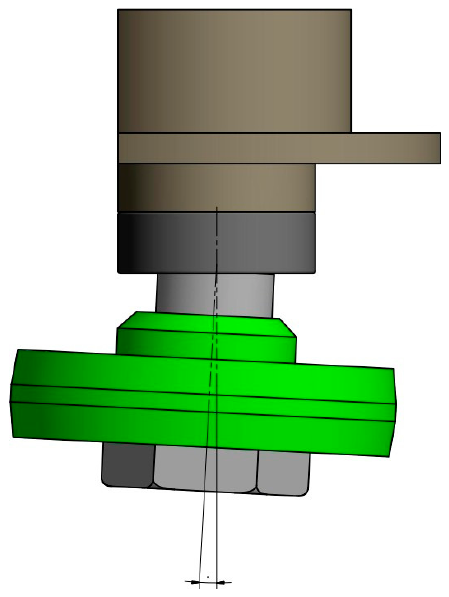
Figure 8. Schematic drawing of the displacement (around the self-aligning ball bearing center) provided by the friction wheel mechanism.